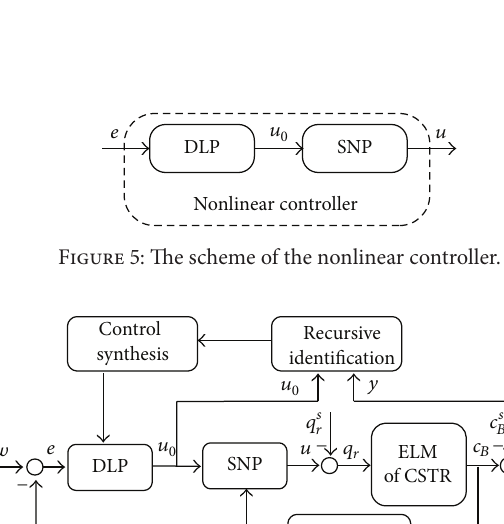
Figure 4: Results of dynamic analysis for the step changes of the volumetric flow rate of the reactant, Δ𝑞 𝑟 .